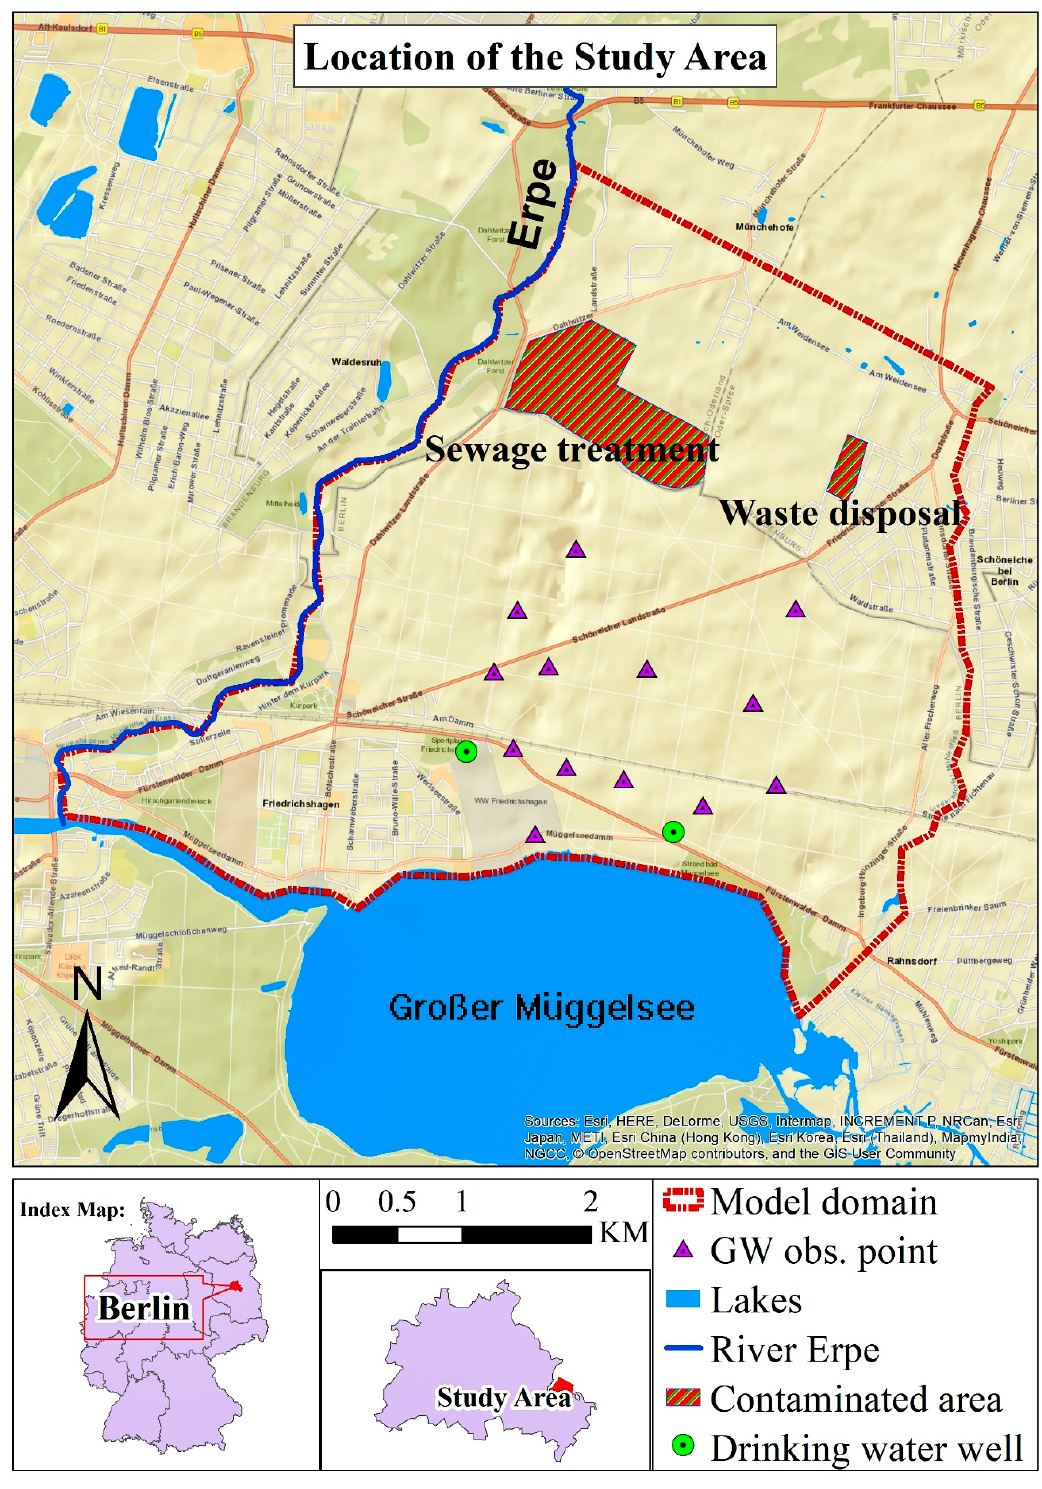
Figure 1. Study domain of this study.